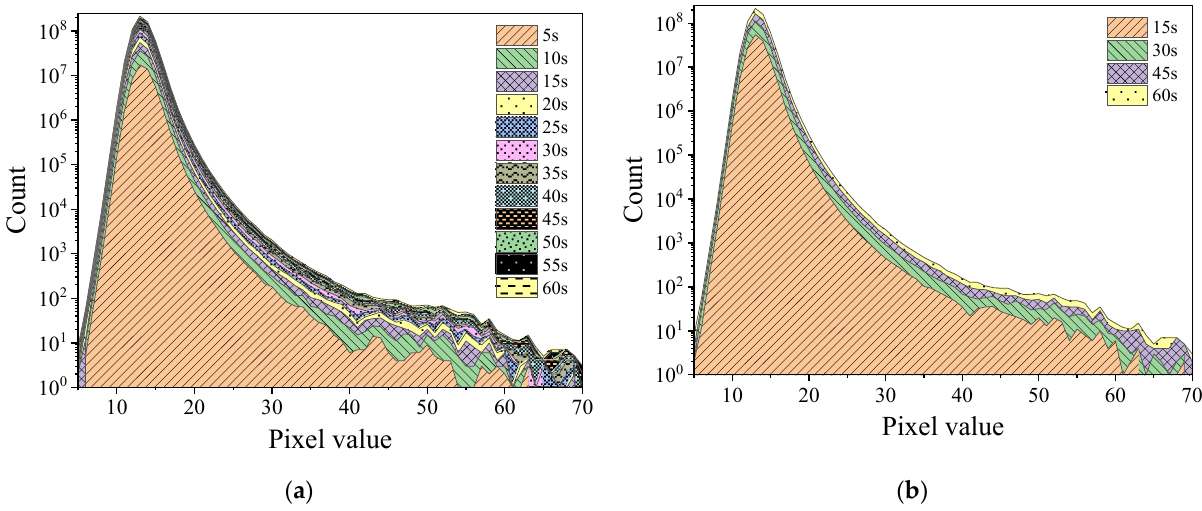
Figure 4. Histogram of the accumulation of Am-Be source radiation signal over time (24 frames per second). ( a ) Stacking once every 5 s. ( b ) Stacking once every 15 s.